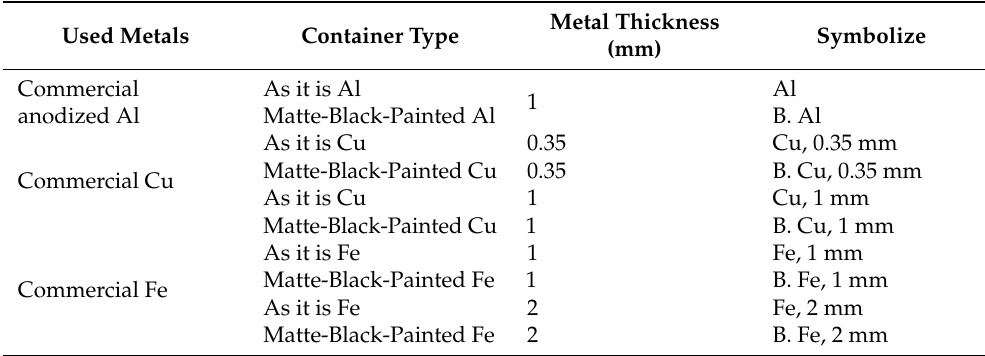
Table 2. Details of the used water containers of different metals and thicknesses, non-painted and